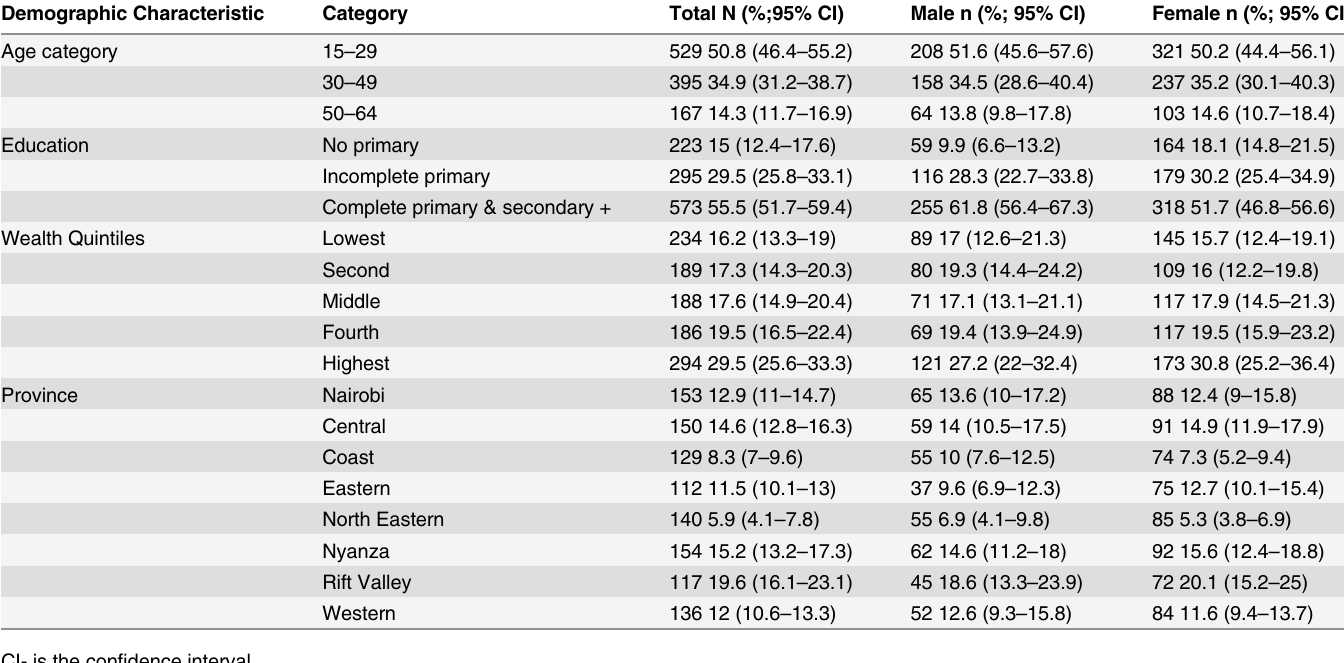
Table 1. Demographic characteristics of study participants aged 15 – 64 years who were sampled for serologic survey of DEN, RVF and CHIK viruses, Kenya 2007. Demographic